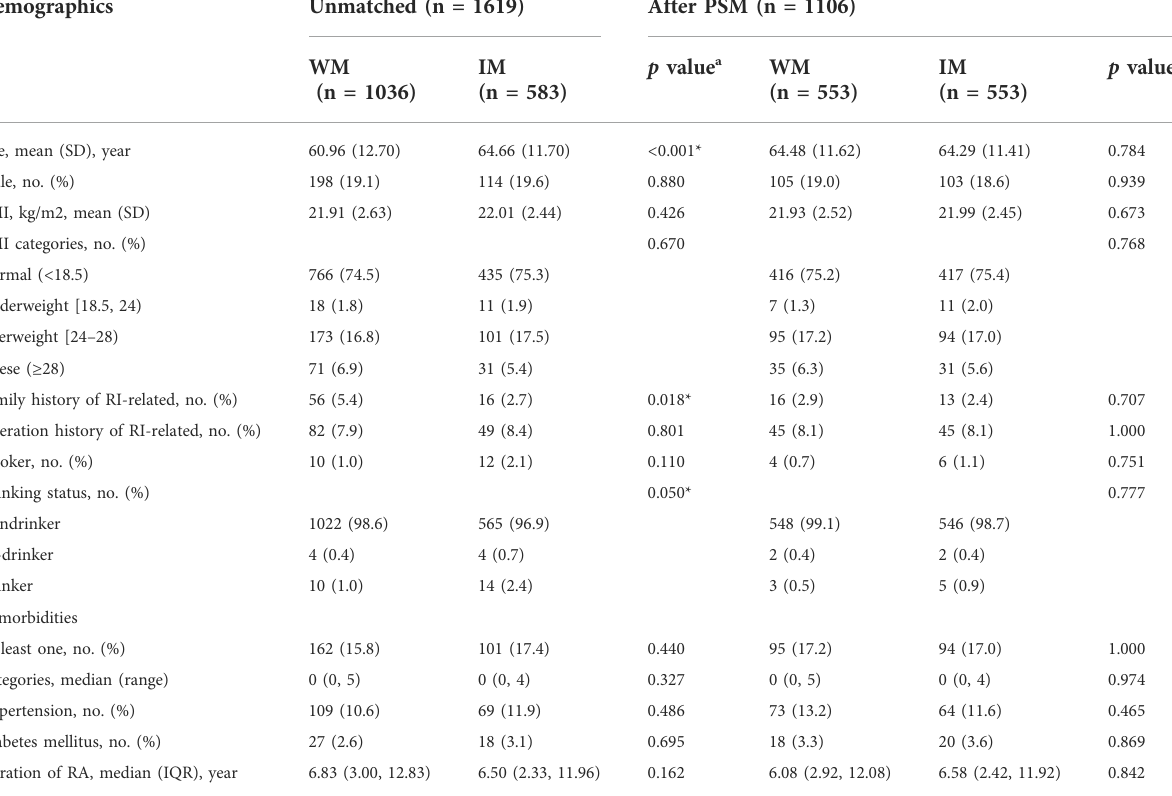
TABLE 2 Patient characteristics before and after PSM in PP